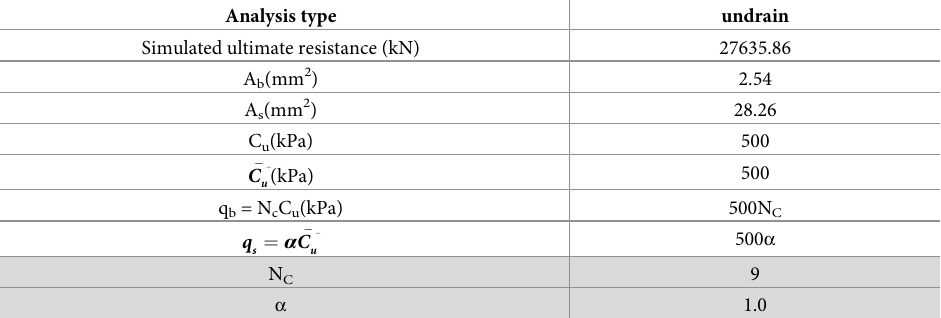
Table 2. Bearing capacity coefficient and skin friction coefficient for piles in cement treated